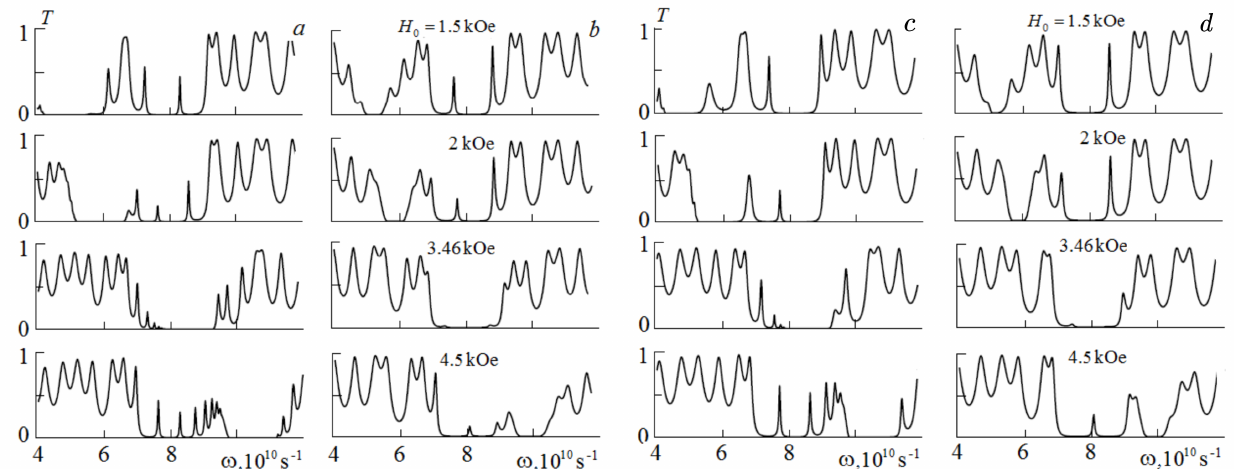
Figure 5. Transmission spectra of TE and TM waves with a cavity thickness L 3 = λ 0 /2 = 1.178 cm ( a , b ) and L 3 = λ 0 /4 = 0.589 cm ( c , d ) filled with a finely layered medium at different values of the magnetic field.